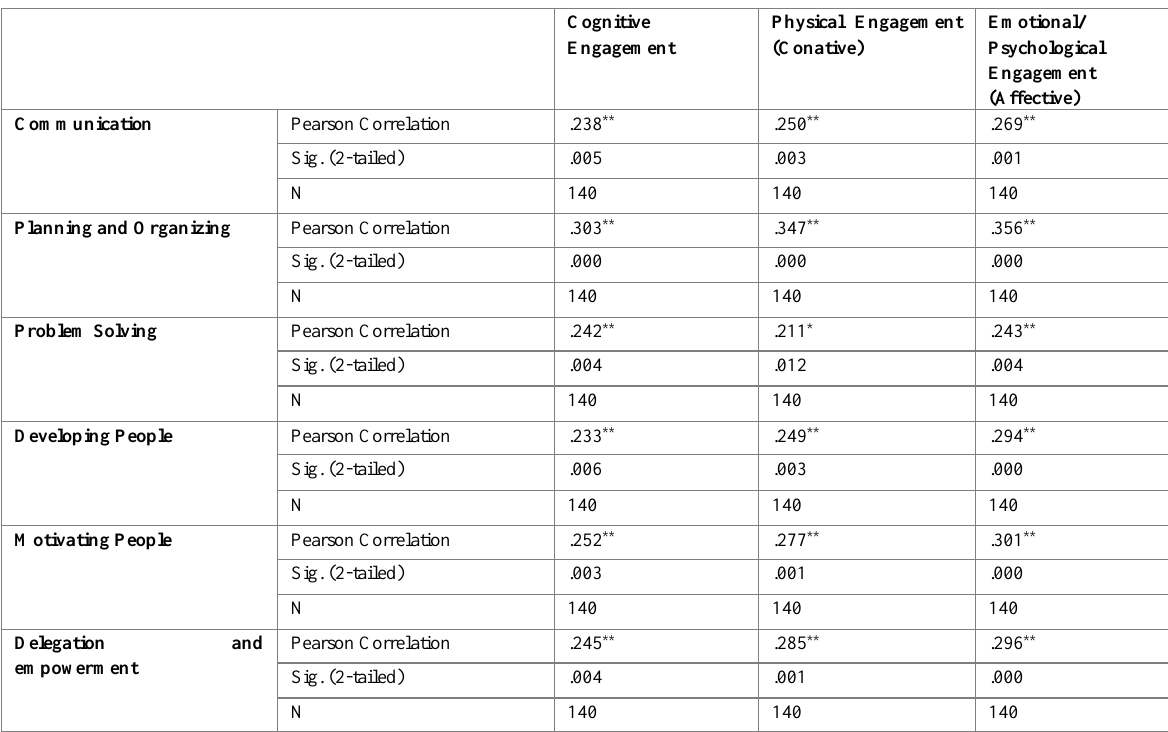
Table 12: Relationship between Leadership Skills and Work